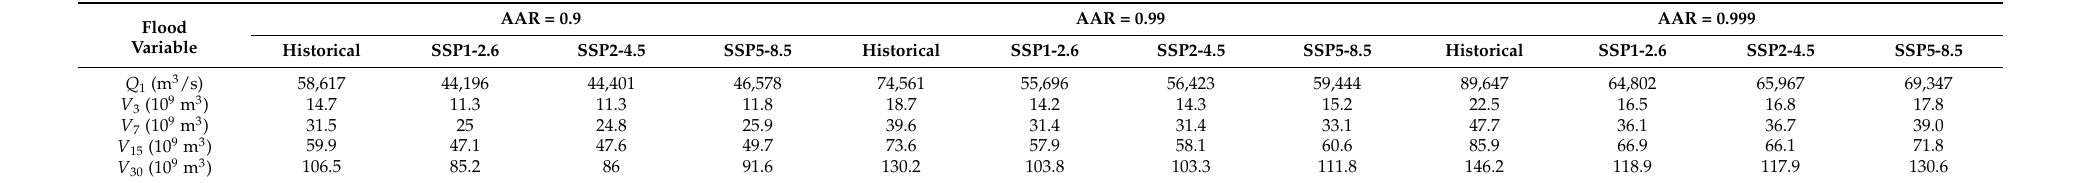
Table 5. Multivariate dam-site design floods associated with AND exceedance probability for the TGR.